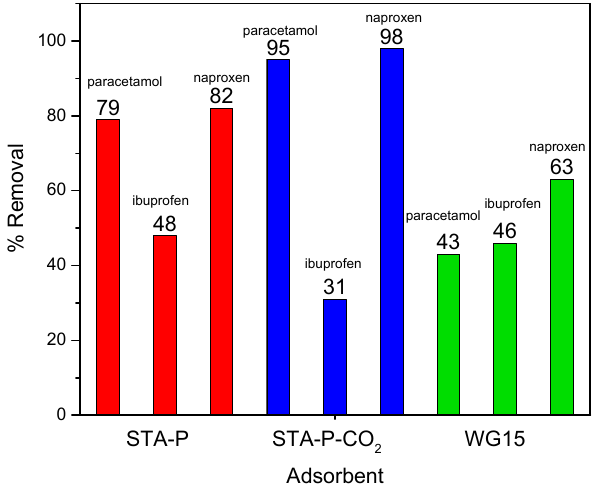
Figure 5. Removal efficiency of paracetamol, ibuprofen, and naproxen for the studied carbon adsorbents (concentration of adsorbate solutions–300 mg dm − 3 , mass of adsorbent–0.01 g, temp. 20 °C).